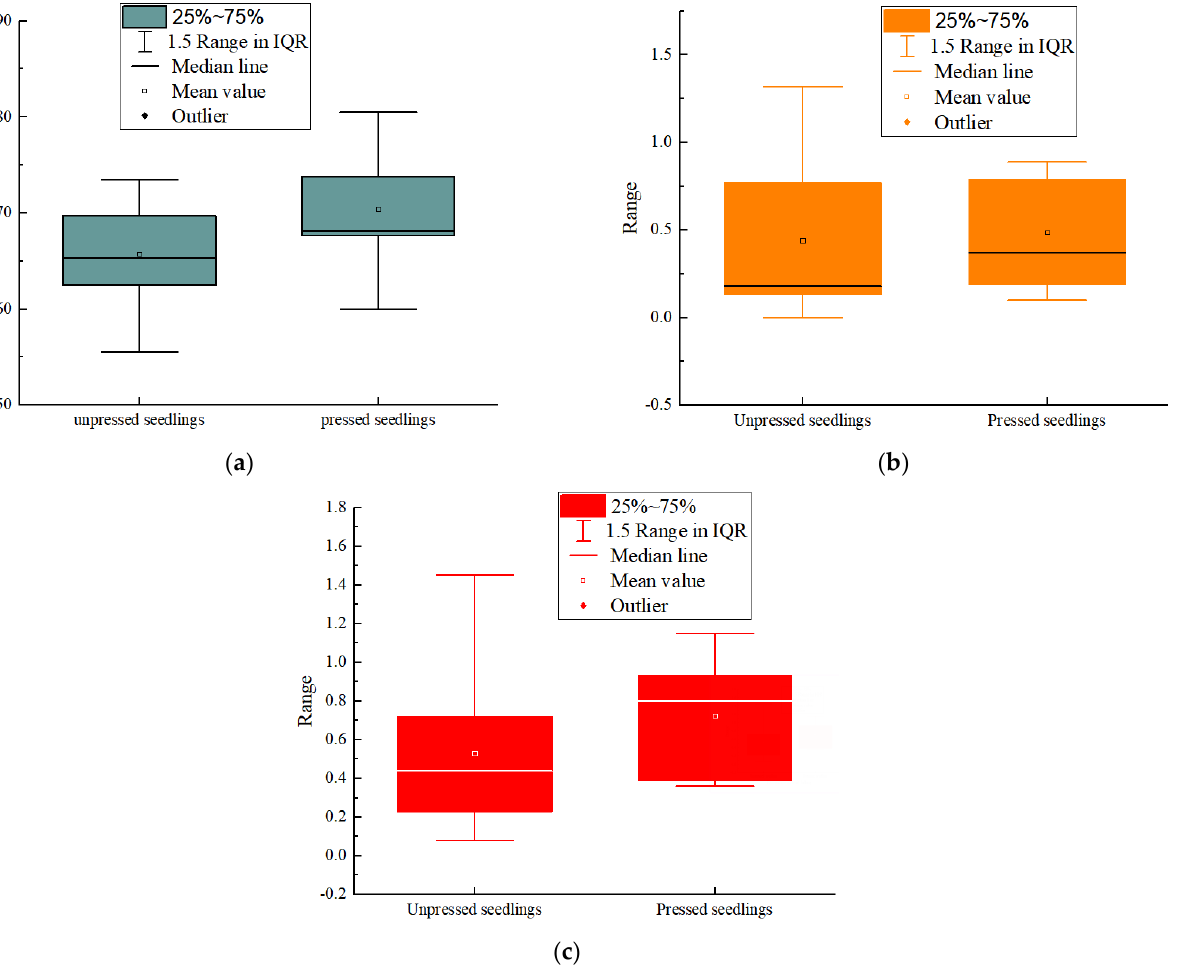
Figure 7. Box diagram of paired samples. ( a ) the rate of vines inverting; ( b ) the rate of buried pods; ( c ) the rate of fallen pods.